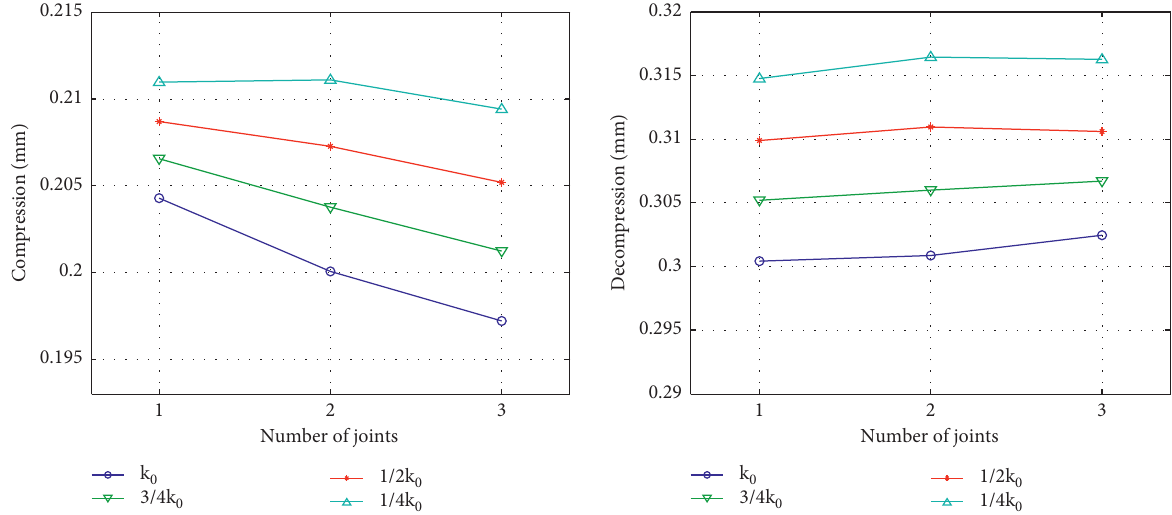
Figure 23: Peak deformation of joint in different